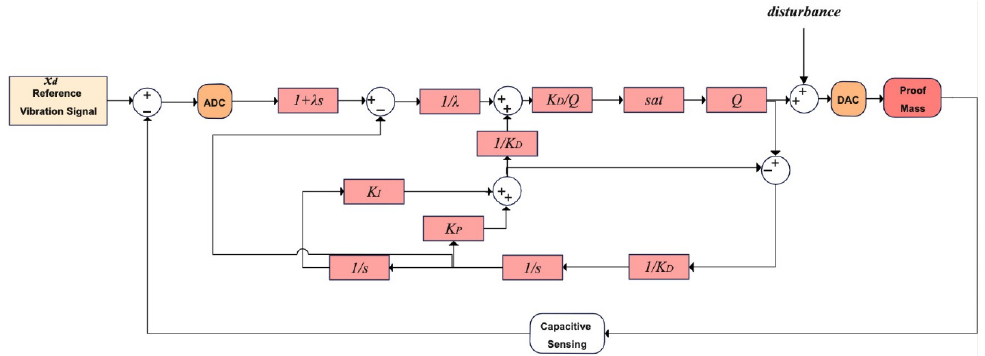
Figure 6. PBSMC for Gyro Drive Axis Control.